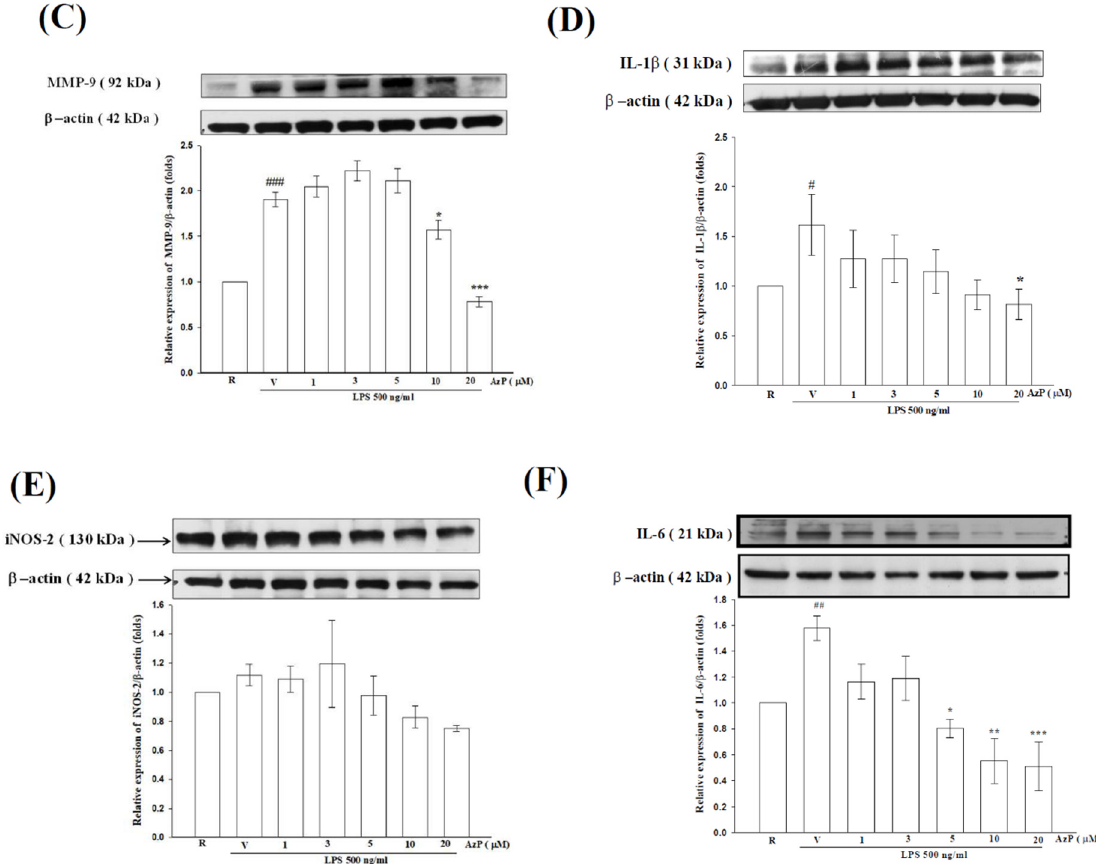
Figure 5. Hierarchical clustering and KEGG analyses of gene profiles of the AzP-manipulated IEC-6 cells. ( A ) Two independent experiments were performed, samples were named C1, C2 as control group (1% dimethyl sulfoxide (DMSO)); LPS1, LPS2 as lipopolysaccharide (LPS) 500 ng/mL group; LPS + AzP1, LPS + AzP2 as LPS 500 ng/mL and AzP 20 µ M group. Heat maps showing the clustering analysis of the IEC-6 cells with different treatments (1% DMSO, LPS 500 ng/mL and/or AzP 20 µ M) indicates up-regulation (red), down-regulation (green), and mean gene expression (black). ( B ) DAVID KEGG pathway analysis of these genes indicates that several pathways were significantly involved in the response ( p > 10 of − log10 value). IEC-6 cells were treated with LPS 500 ng/mL for 8 h and/or AzP 1–20 µ M, Western blot performed and immunoblotted with several inflammatory protein expressions including MMP-9 ( C ), IL-1 β ( D ), iNOS ( E ), and IL-6 ( F ). Density was measured and calculated. ### p < 0.001 as compared with the control, ## p < 0.01 as compared with the control, # p < 0.05 as compared with the control, * p < 0.05 as compared with the LPS-treated group, ** p < 0.01 as compared with the LPS-treated group and *** p < 0.001 as compared with LPS-treated